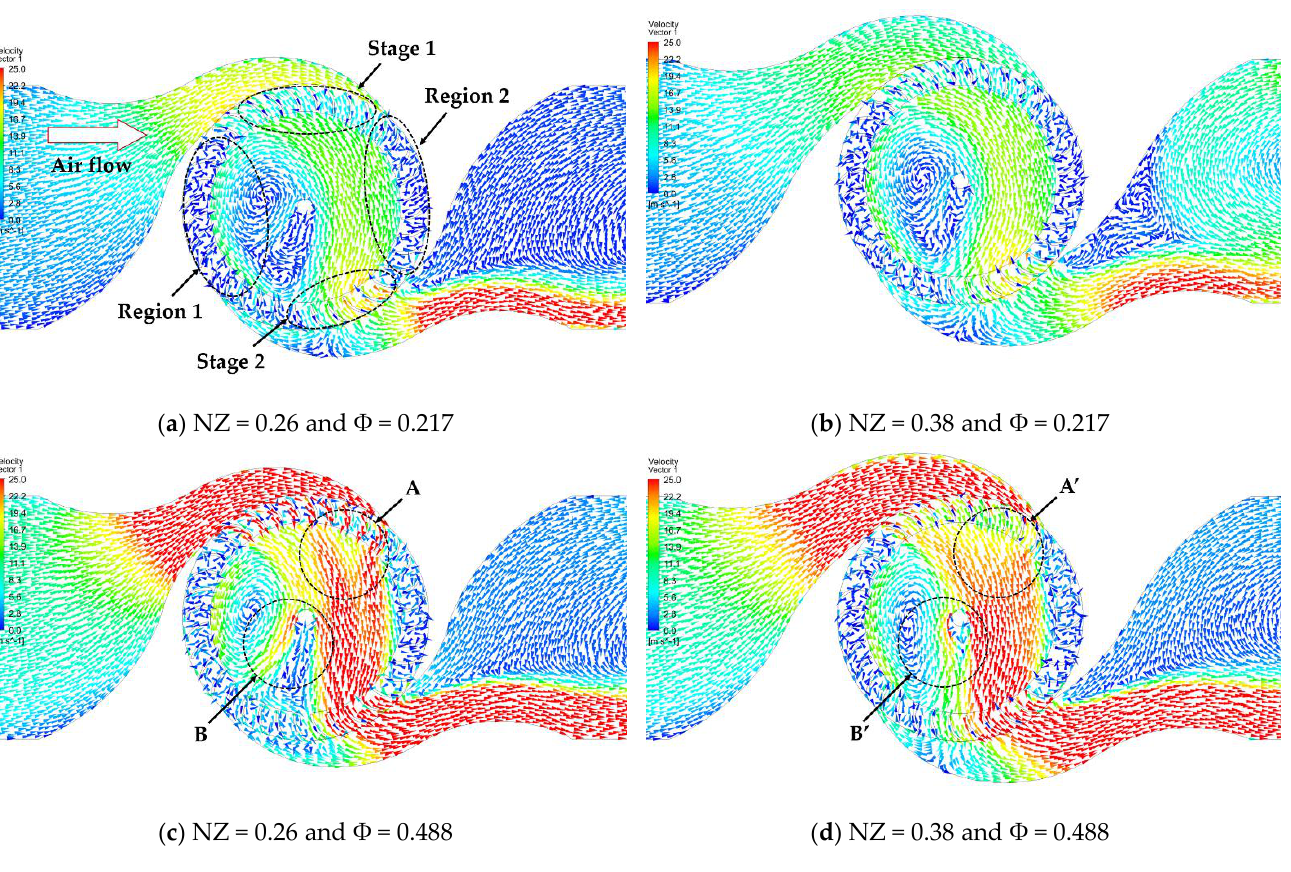
Figure 8. Comparison of velocity vectors between NZ = 0.26 and 0.38 at ω = 700 rpm, Nb = 36, and t* = 3 mm. t* = 3